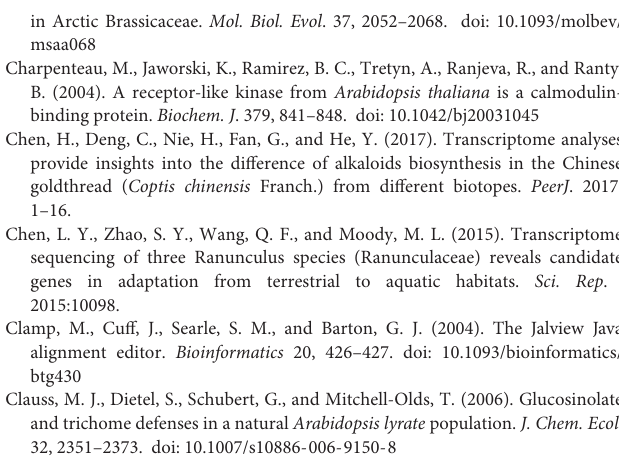
Supplementary Figure 1 | The assembly completeness test for the transcriptome of each species. Supplementary Figure 2 | Gene Ontology (GO) annotation for shared orthologs from Urophysa rockii and Urophysa henryi . Supplementary Figure 3 | Gene Ontology function analysis of the significantly enriched orthologs shared from U. rockii and U. henryi . Supplementary Figure 4 | The directed acycling graph revealed from the shared orthologs from U. rockii and U. henryi . Supplementary Figure 5 | Gene Ontology annotation for shared orthologs from non-karst species Semiaquilegia adoxoides , Aquilegia ecalcarata, and Aquilegia coerulea . Supplementary Table 1 | The function annotation and adaptive significance test for the 243 clusters of paralogous genes. Supplementary Table 2 | The GO annotation for all 335 PSGs detected from Urophysa species. Supplementary Table 3 | The KEGG annotation results for 335 PSGs detected from Urophysa